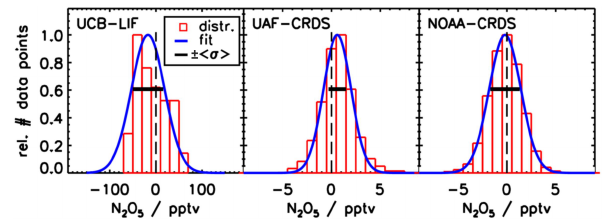
Fig. 2. Distribution of N 2 O 5 measurements during times, when in- struments sampled zero air from the clean chamber, before trace gases were injected. Only UCB-LIF, UAF-CRDS and NOAA- CRDS provided a sufficiently large number of data points for this analysis. Data are fitted to a gaussian distribution, whose width ( ± 1 σ ) is compared to the mean of the measurement errors ( ±h σ i